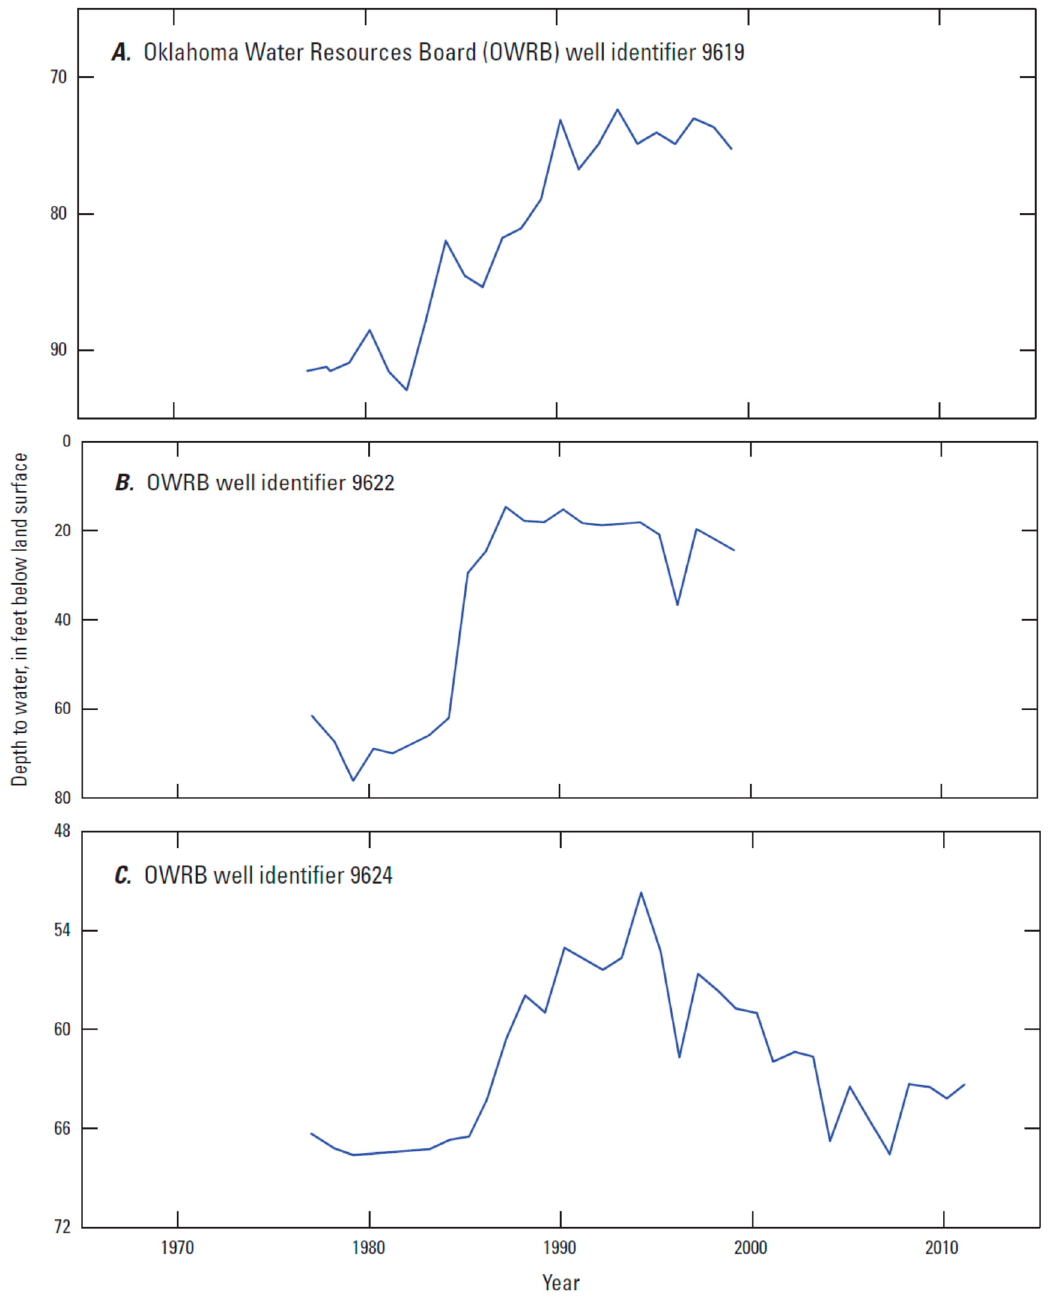
Figure 3. Water levels from Oklahoma Water Resources Board (OWRB) Mass Measurement Program wells. Source: Mashburn et al. [27]. ( A ) Well 9619, ( B ) Well 9622, ( C ) Well 9624.